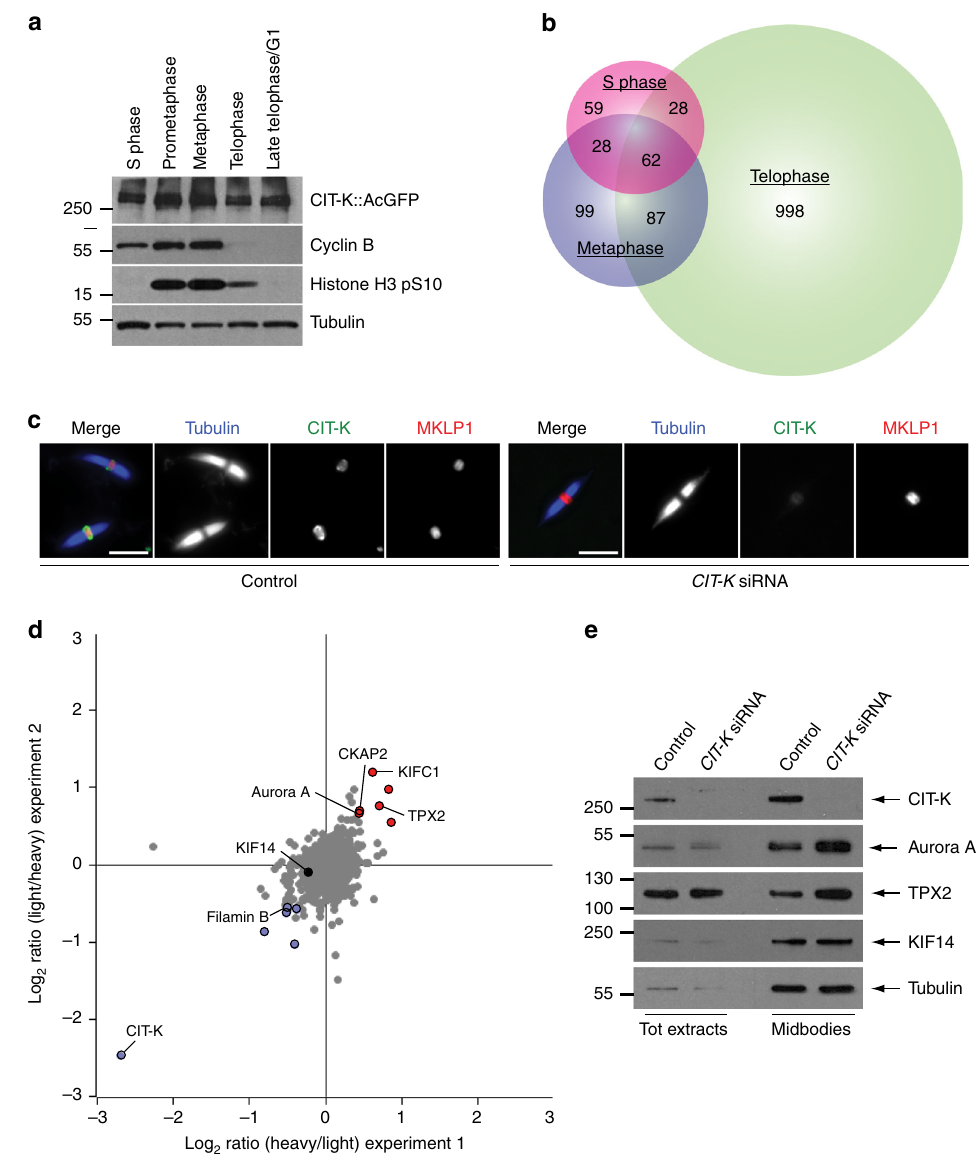
Fig. 1 CIT-K speci fi cally interacts with a multitude of proteins in cytokinesis. a Western blot analysis of protein extracts from HeLa cells stably expressing a CIT-K::AcGFP transgene synchronized at different stages of the cell cycle. The blots were probed with antibodies against the proteins indicated to the right. Numbers on the left indicate the size, in kDa, of the protein ladder. b Proportional Venn diagram showing the number of proteins identi fi ed at each cell cycle stage by AP-MS using CIT-K::AcGFP as bait. c Midbodies puri fi ed from HeLa S3 cells treated with siRNAs directed against either a random sequence (control) or CIT-K were fi xed and stained to detect tubulin, CIT-K, and MKLP1. Scale bars, 5 µ m. d Logarithmic normalized protein ratios from two independent SILAC experiments were plotted against each other. Each point represents a single protein identi fi ed. Gray dots correspond to proteins that did not show any signi fi cant difference in abundance between control and CIT-K siRNA midbodies. Red and blue dots represent proteins that were either signi fi cantly enriched or less abundant after CIT-K depletion in both biological replicates ( p value < 0.01; signi fi cance B test corrected by Benjamini- Hochberg method). e Western blot analysis of total protein extracts and midbodies puri fi ed from telophase HeLa S3 cells treated with siRNAs directed against either a random sequence (control) or CIT-K . The blots were probed with antibodies against the proteins indicated to the right. Numbers on the left indicate the size, in kDa, of the protein ladder. Source data for Fig. 1a and e are provided as a Source Data fi